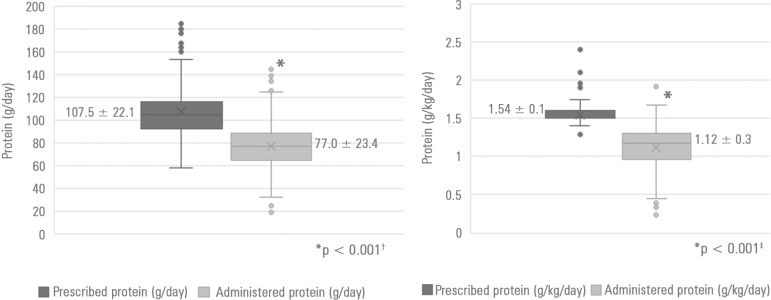
Differences between means of prescribed versus
administered protein in adult critically ill patients receiving only
nutritional therapy.† Paired Student's test; ‡ Wilcoxon
test.